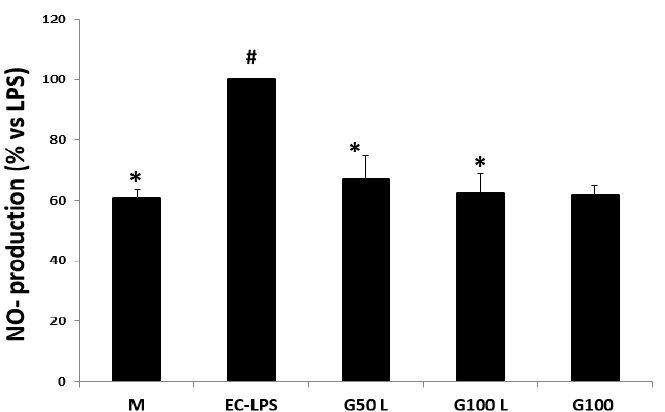
Figure 7. GAAE pre-treatment effect on NO production in normal controls challenged with EC- LPS . Biopsies were treated only with medium culture (M), or with 1 mg/mL of EC-LPS or pretreated for 3 h with 50 and 100 µ g/mL GAAE, then challenged for 18 h with EC-LPS (G50 L and G100 L), or treated only with 100 µg/mL GAAE (G100). Results are expressed as means ± S.E.M. ( N = 15), * p < 0 . 05 vs. EC - LPS, # p < 0 . 05 vs. medium (Student’s t - test).